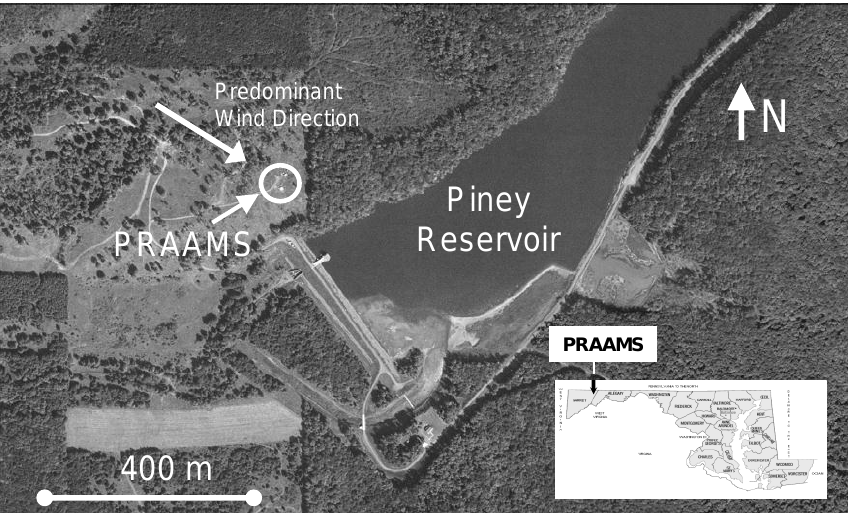
Figure 1. The Piney Reservoir Ambient Air Monitoring site (PRAAMS).